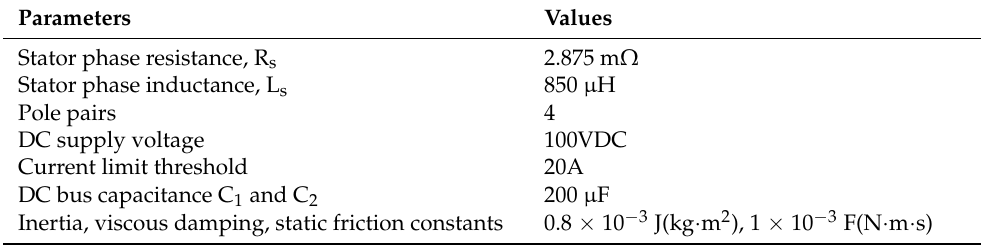
Table 2. Motor specifications.